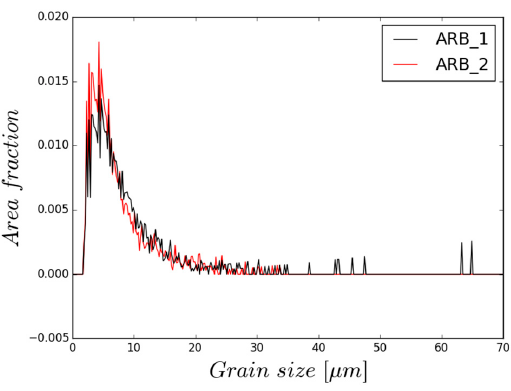
Figure 5. Grain size distribution of ARB_1 and ARB_2 sample calculated from EBSD data.